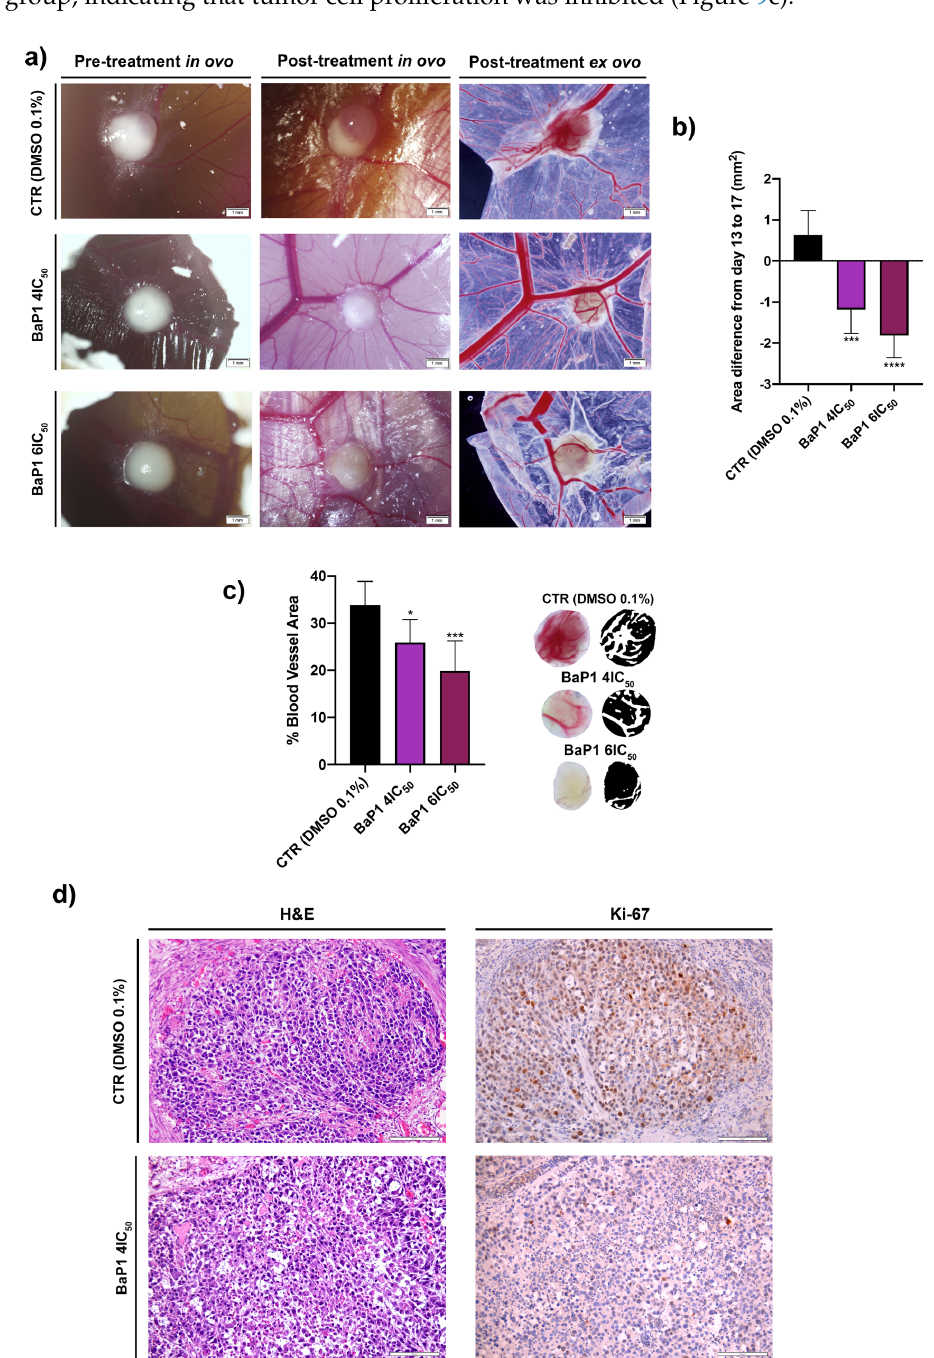
Figure 9. In vivo effects of BaP1. ( a ) Representative pictures of chicken embryo choriollantoic membrane (CAM) in ovo pre-treatment (day 13) and post-treatment (day 17). CAMs were exposed to DMSO (0.1%) (control group), BaP1 4 × IC 50 , and 6 × IC 50 for 4 days. ( b ) Quantification of tumor area (difference from day 13 to day 17). ( c ) Quantification of the percentage of blood vessel area. Statistical analysis was performed by one-way ANOVA (* p < 0.05, *** p < 0.001, **** p < 0.0001). ( d ) Representative pictures of hematoxylin and eosin (H&E) staining and Ki-67 expression for the control group and BaP1 4 × IC 50 treated CAMs; scale bar = 100 µ